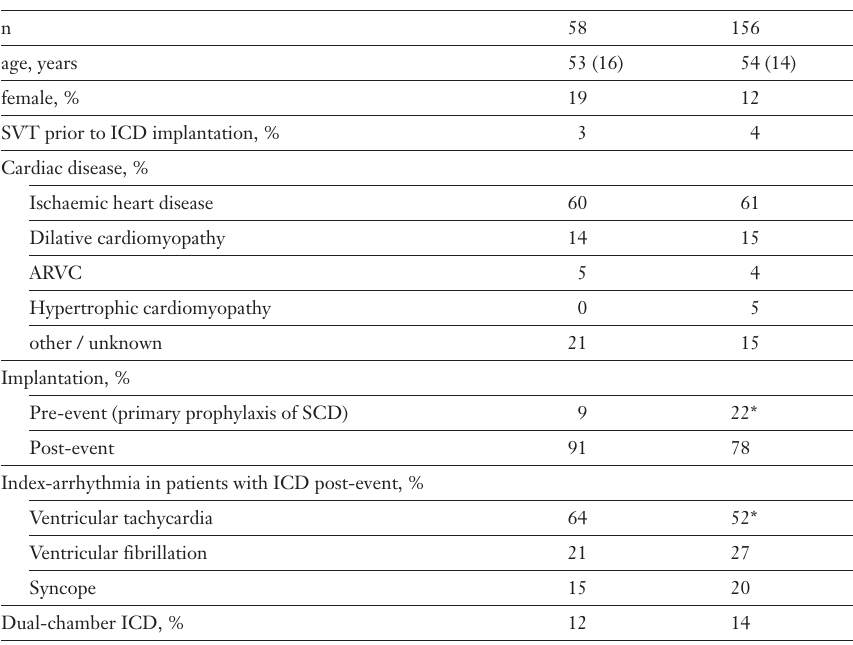
Characteristics of pa- tients with and with- out inappropriate ICD interventions (IRx).